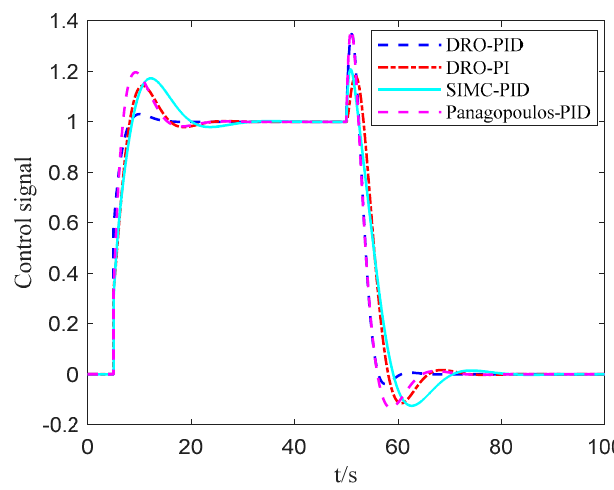
Figure 9. The output response of the step set-point and input disturbance for Example 2.